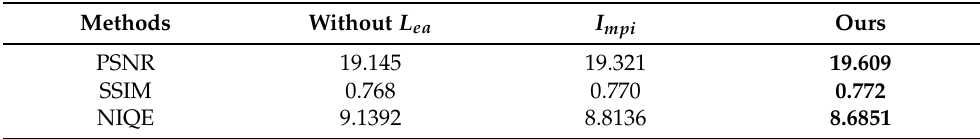
Figure 8. Comparison results of ablation study. Table 2. Comparison of performance metrics for ablation study.